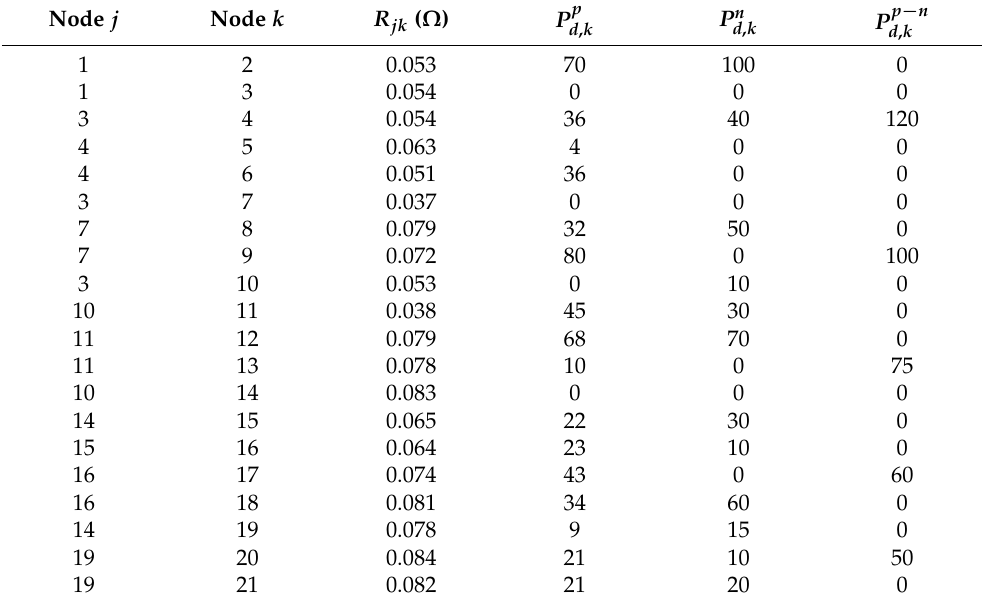
Table 1. Parametric information regarding the 21-bus grid (all powers in kW). Node j Node